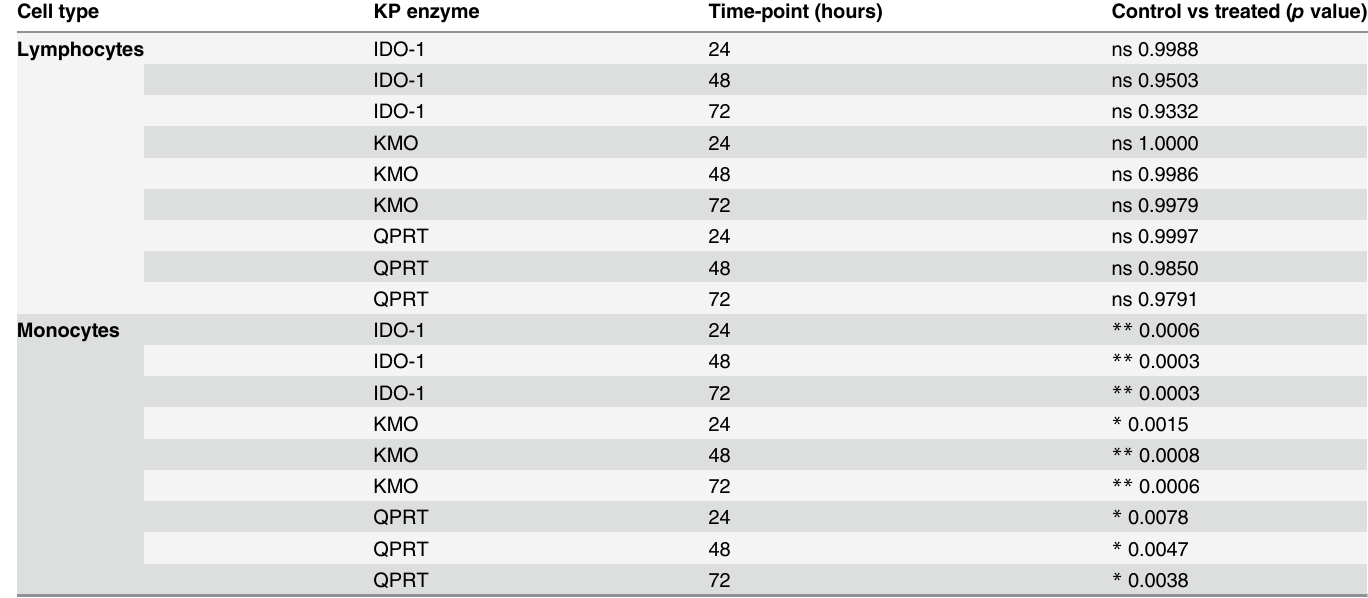
Table 2. Significance difference levels between control and treatment groups for IDO-1, KMO and QPRT expression (gMFI) for both lymphocytes and monocytes at each time-point